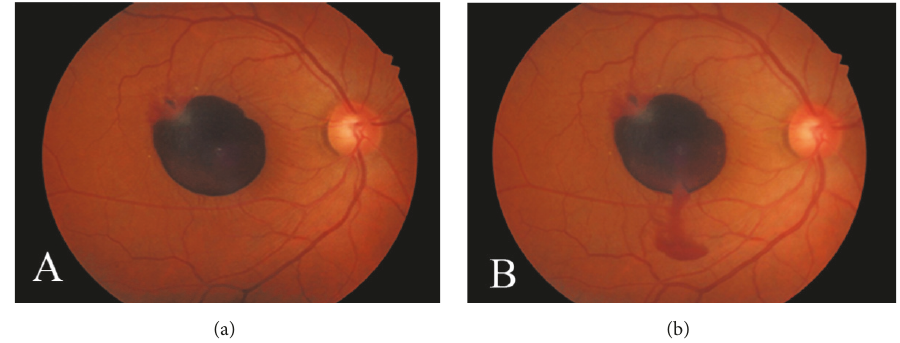
Figure 1: A 55-year-old man had sudden decreased visual acuity in the right eye. (a) Fundus photography of the right eye shows multilevel macular hemorrhage occupying nearly the half of macular area within the vascular arcade. Note the round dark hemorrhage which was considered to be a hemorrhagic detachment of ILM and a more superficially situated lighter-colored hemorrhage considered to be subhyaloid hemorrhage. (b) An immediate stream of blood into the vitreous through the photodisruption cleft is seen after the laser